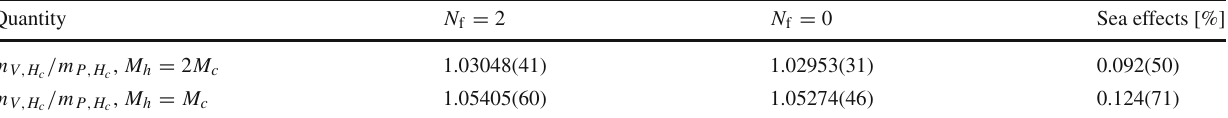
/ m P , H c in the continuum limit for both the N f c